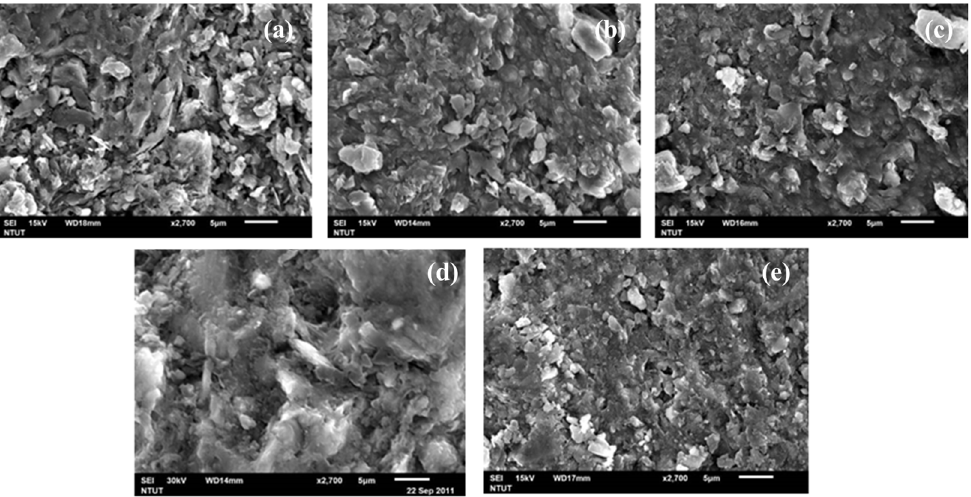
Figure 7. SEM images of LTGS bricks made at temperatures between 100 °C to 500 °C: (a)100 °C ; (b) 200 °C ; (c) 300 °C ; (d) 400 °C ; (e) 500 °C.